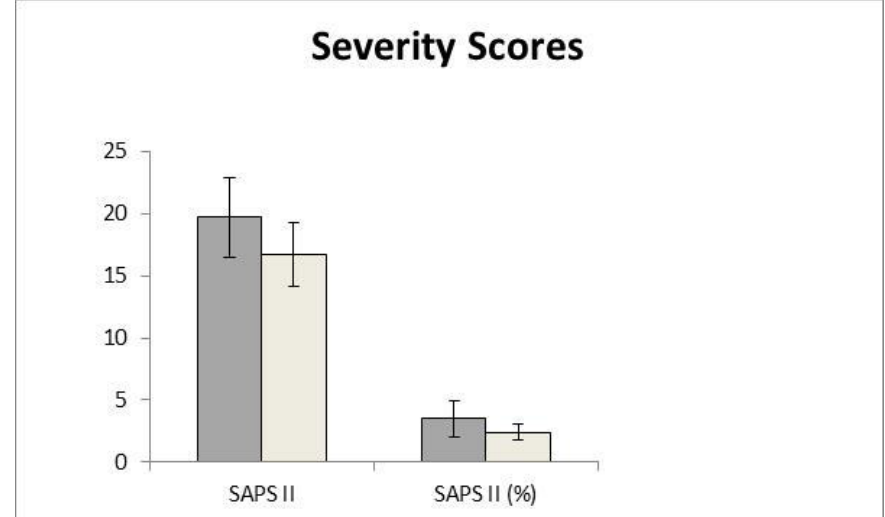
Figure 2. Severity scores SAPS II and SAPS% in the two groups of patients: discharged (light gray), deceased (dark grey).